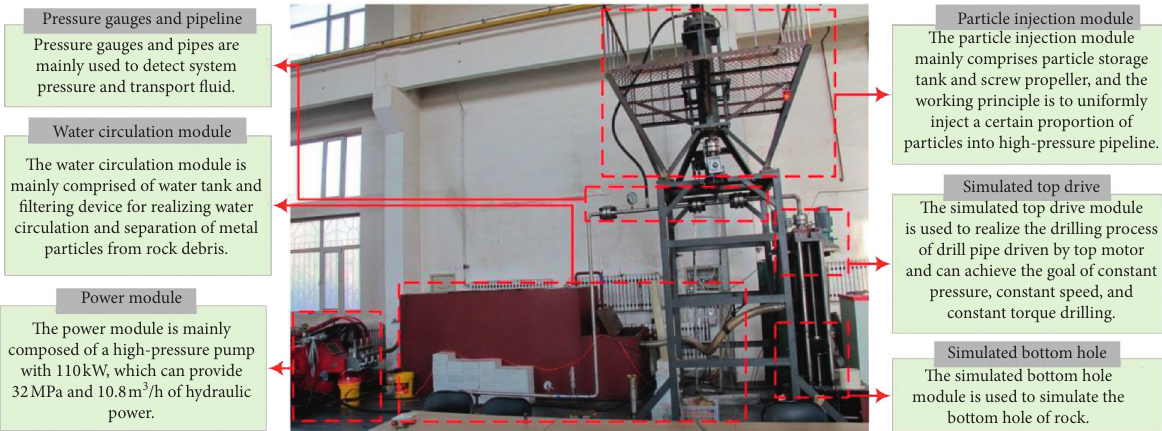
Figure 1: Particle jet impact rock-breaking laboratory device.